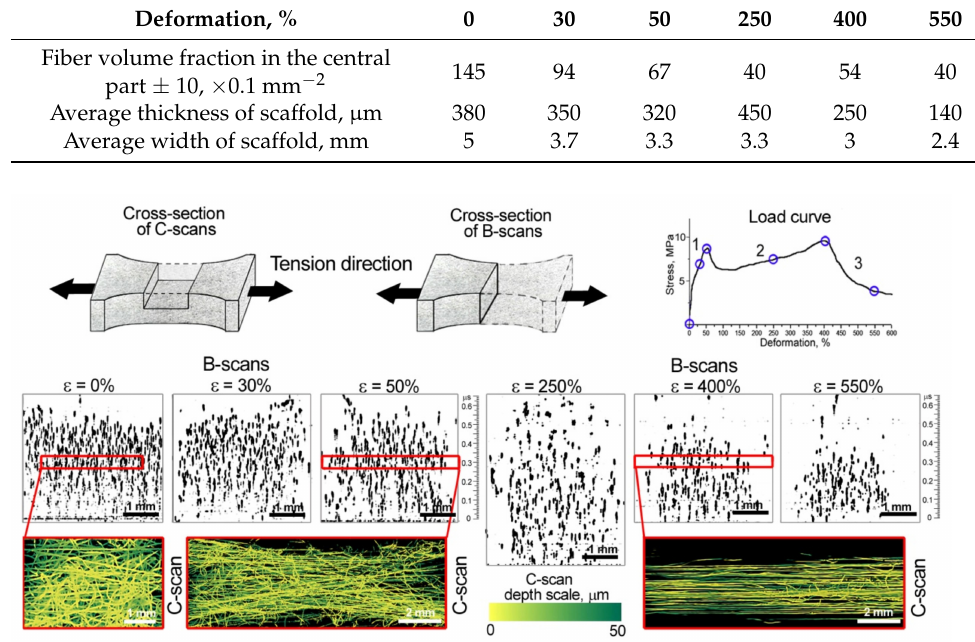
Figure 5. Ultrasound imaging of fiber packing density at different stages of deformation ε . B-scans were obtained from the central regions of the tested nonwoven sample. To display the vertical cross-sections (B-scans), the signal amplitudes were taken modulo. The color C-scans depict the distribution of fibers over a thickness of 50 µ m at the middle depth of the scaffold, under a load corresponded to two peak points at elongations of 50 and